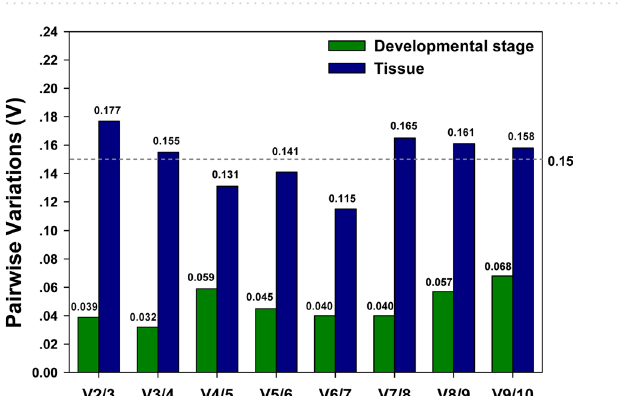
Figure 4. Expression stability of candidate reference genes. The geometric means of the expressional stability were comprehensively calculated by RefFinder for candidate reference genes in different developmental stages and tissues, and the lower value of geometric mean denotes higher expressional stability.